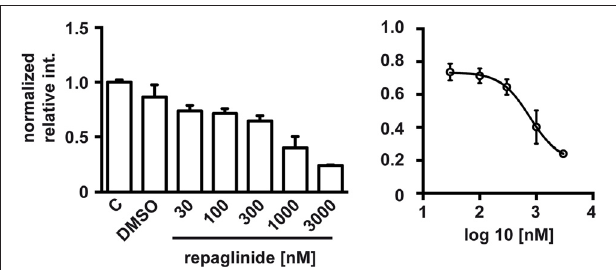
FIGURE 4 | Repaglinide reduces endoproteolysis of endogenous PS2 in N2a cells. Cultures were untreated (C), treated with vehicle (DMSO) or with increasing concentrations of repaglinide. Whole cell extracts were analyzed by immunoblot with anti-PS2 antibody and band intensities quantified (left). The IC50 value (0.76 µ M) was estimated after non-linear regression analysis (log(antagonist) vs. response (four parameters)) of the resulting dose-response curve (right; n =